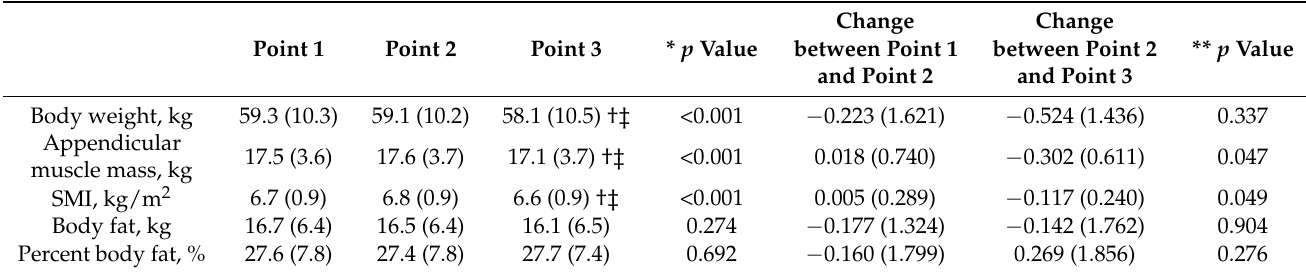
Table 2. Changes in body composition before and after the start of the COVID-19 pandemic.